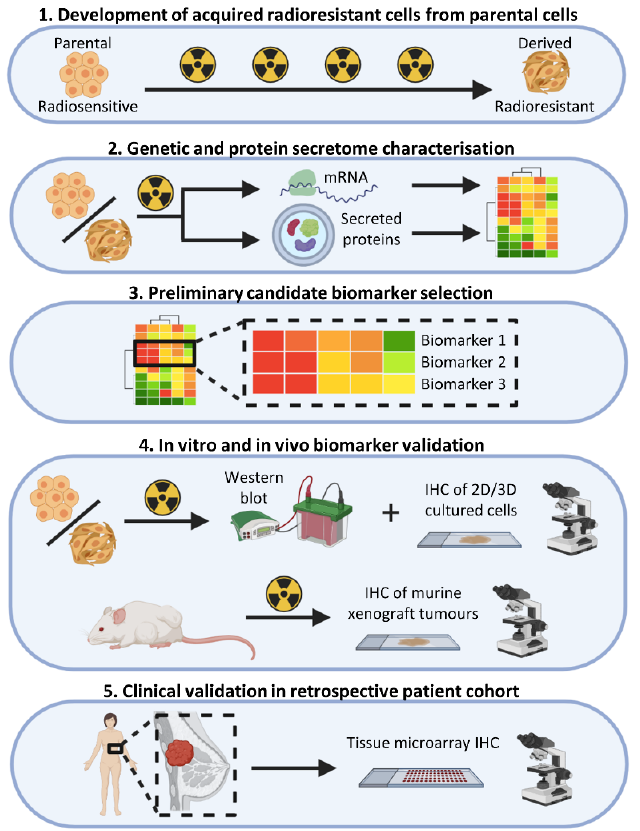
Figure 1. Biomarker discovery pipeline. Outline of the methods used to identify and validate biomarkers of BC RT response. Figure created with Biorender.com.